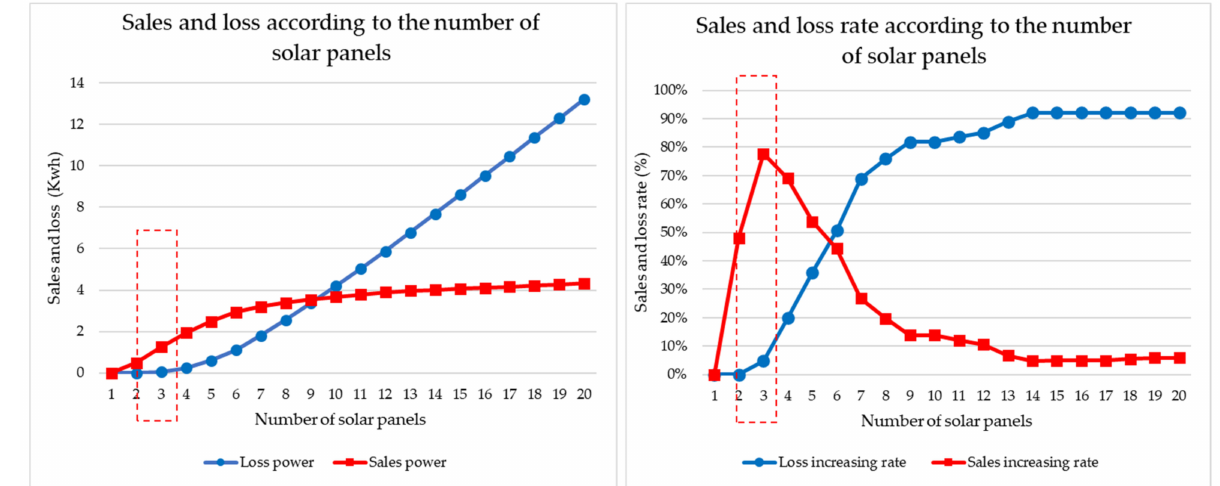
Figure 11. Prosumer’s optimal number of solar panels for each customer traded by Prosumer 1 and Customer 1.